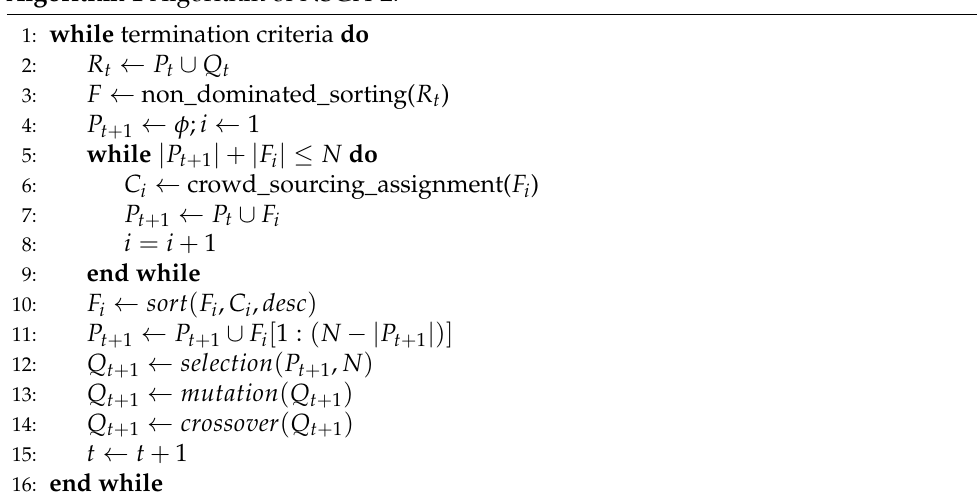
Algorithm 1 Algorithm of